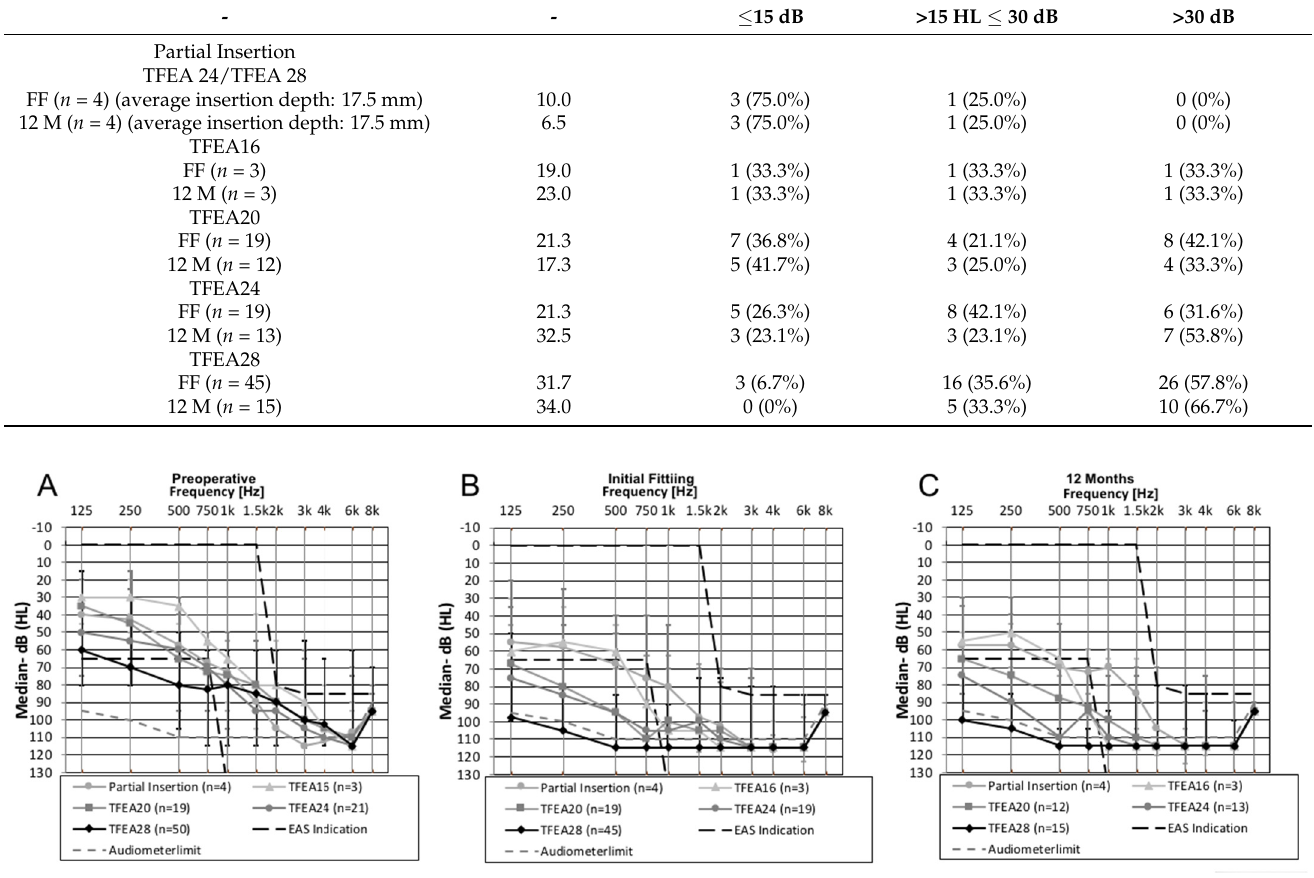
Figure 1. Pre- and postoperative median hearing levels, minimum and maximum for all 97 ears, divided into groups: ( A ) preoperative, ( B ) FF, ( C ) 12-months after FF.